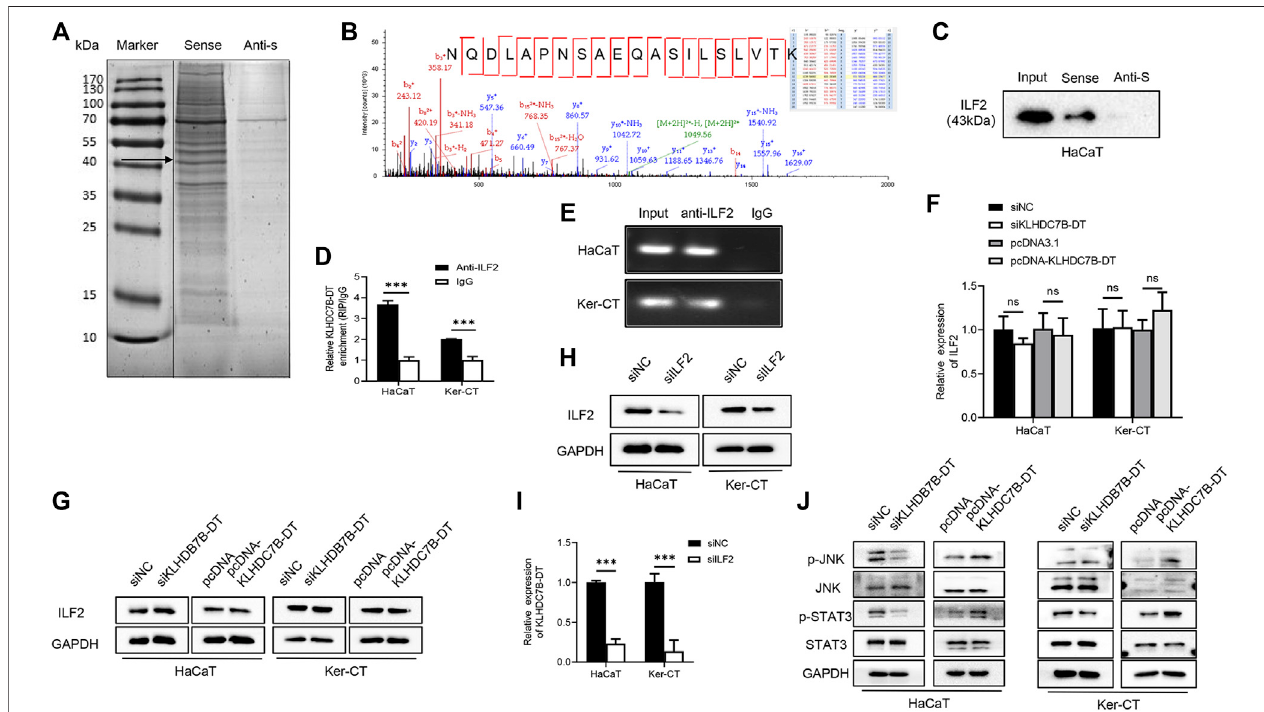
FIGURE4| KLHDC7B-DTcanbindwithILF2proteinandactivateJNK/STAT3signalling. (A) SilverstainingofinteractingproteinsaftertheKLDHC7B-DTpulldown assay. (B) Mass spectrometry of ILF2. (C) Western blotting was used to detect ILF2 in the RNA pulldown product. (D) RIP experiments were performed using an antibodyagainstILF2onlysatesfromHaCaTandKer-CTcells;IgGwasusedasthecontrolgroup. (E) AgaroseelectrophoresisdetectedKLDHC7B-DTinproductsfrom RIP. (F,G) mRNA and protein levels of ILF2 in KLDHC7B-DT knockdown or overexpression keratinocytes. (H) The ef fi ciency of ILF2 knockdown was detected by Western blotting. (I) The mRNA levels of KLDHC7B-DT after ILF2 knockdown. (J) Activation of the STAT/JNK pathway after KLDHC7B-DT knockdown or overexpression. Data are shown as the means ± SD, *** p < 0.001. All experiments were repeated at least three